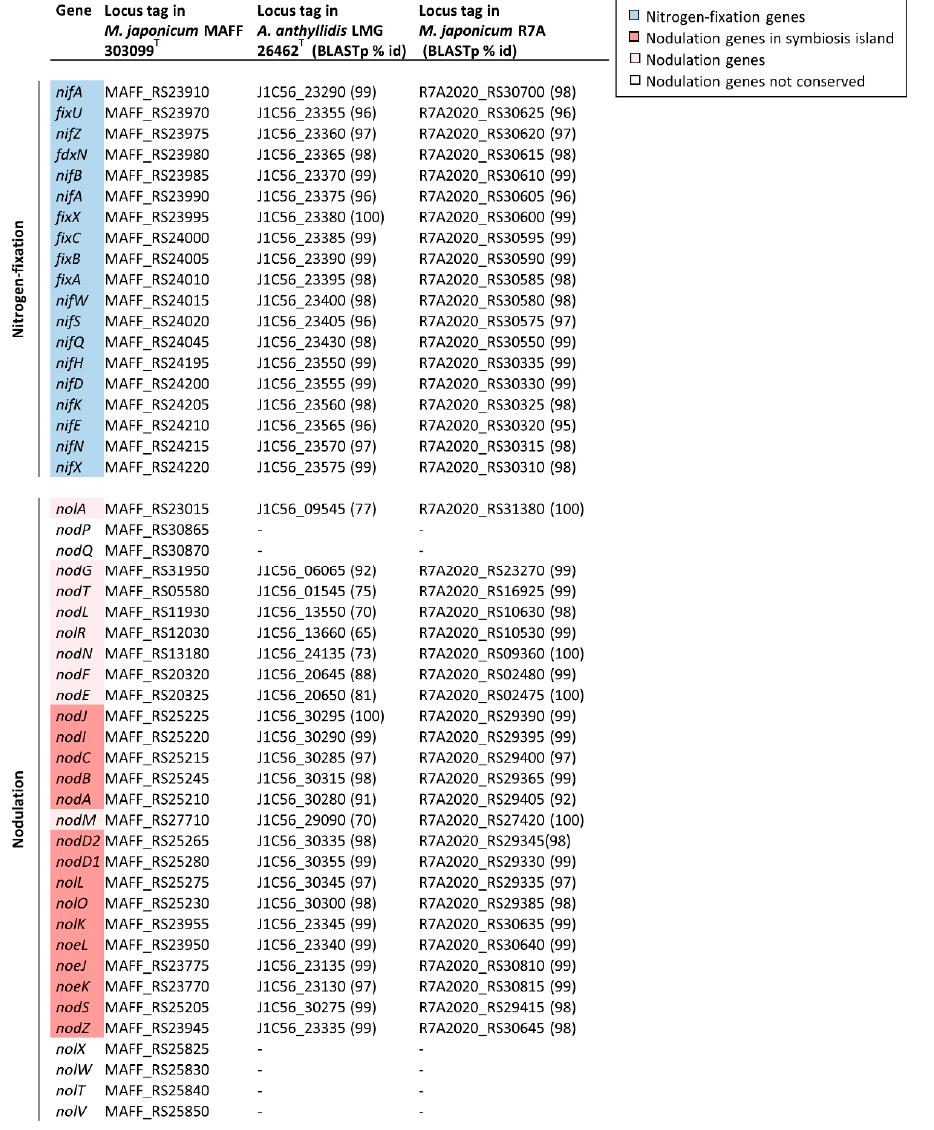
Figure 4. Summary results of BLASTp searches of the translated nucleotide sequences of nitrogen- fixation and nodulation genes from M. japonicum MAFF 303099 T against A. anthyllidis LMG 26462 T and M. japonicum R7A homologs. Putative genes are colored according to nod/nif-fix pathways (see key), where lighter color denotes genes that are not predicted in the symbiosis island, and white denotes the genes not conserved in A. anthyllidis LMG 26462 T and M. japonicum R7A. Hyphen indicates not detected genes.